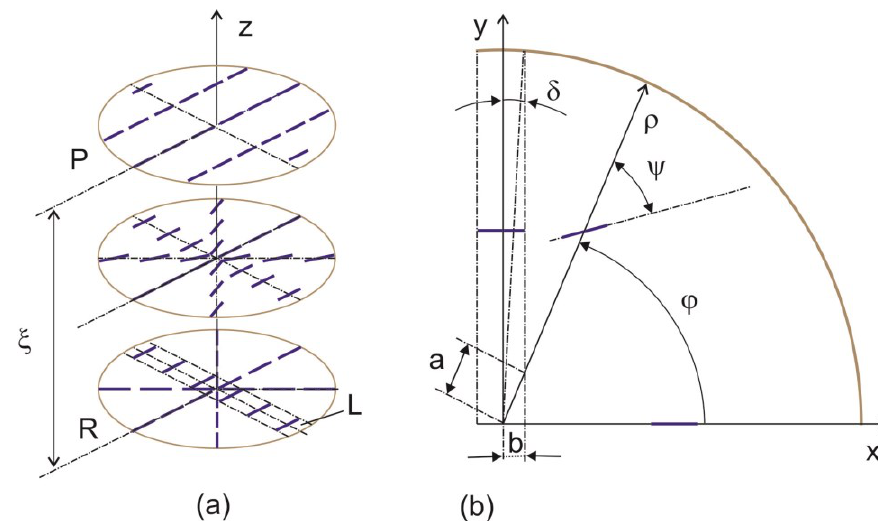
Figure 7. ( a ) Distribution of nematic director field n at the transformation of the radial structure to the uniform planar one at distance ξ from the polymer film surface and ( b ) parameters in the X0Y plane for calculation in cylindrical